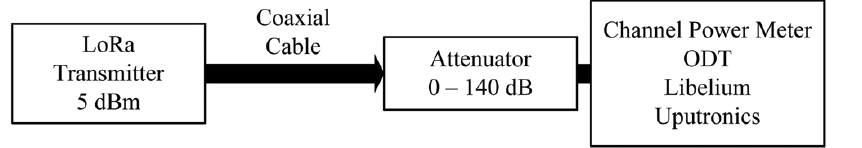
Figure 6. Measurement setup for RSSI correction factors and SNR measurement chain